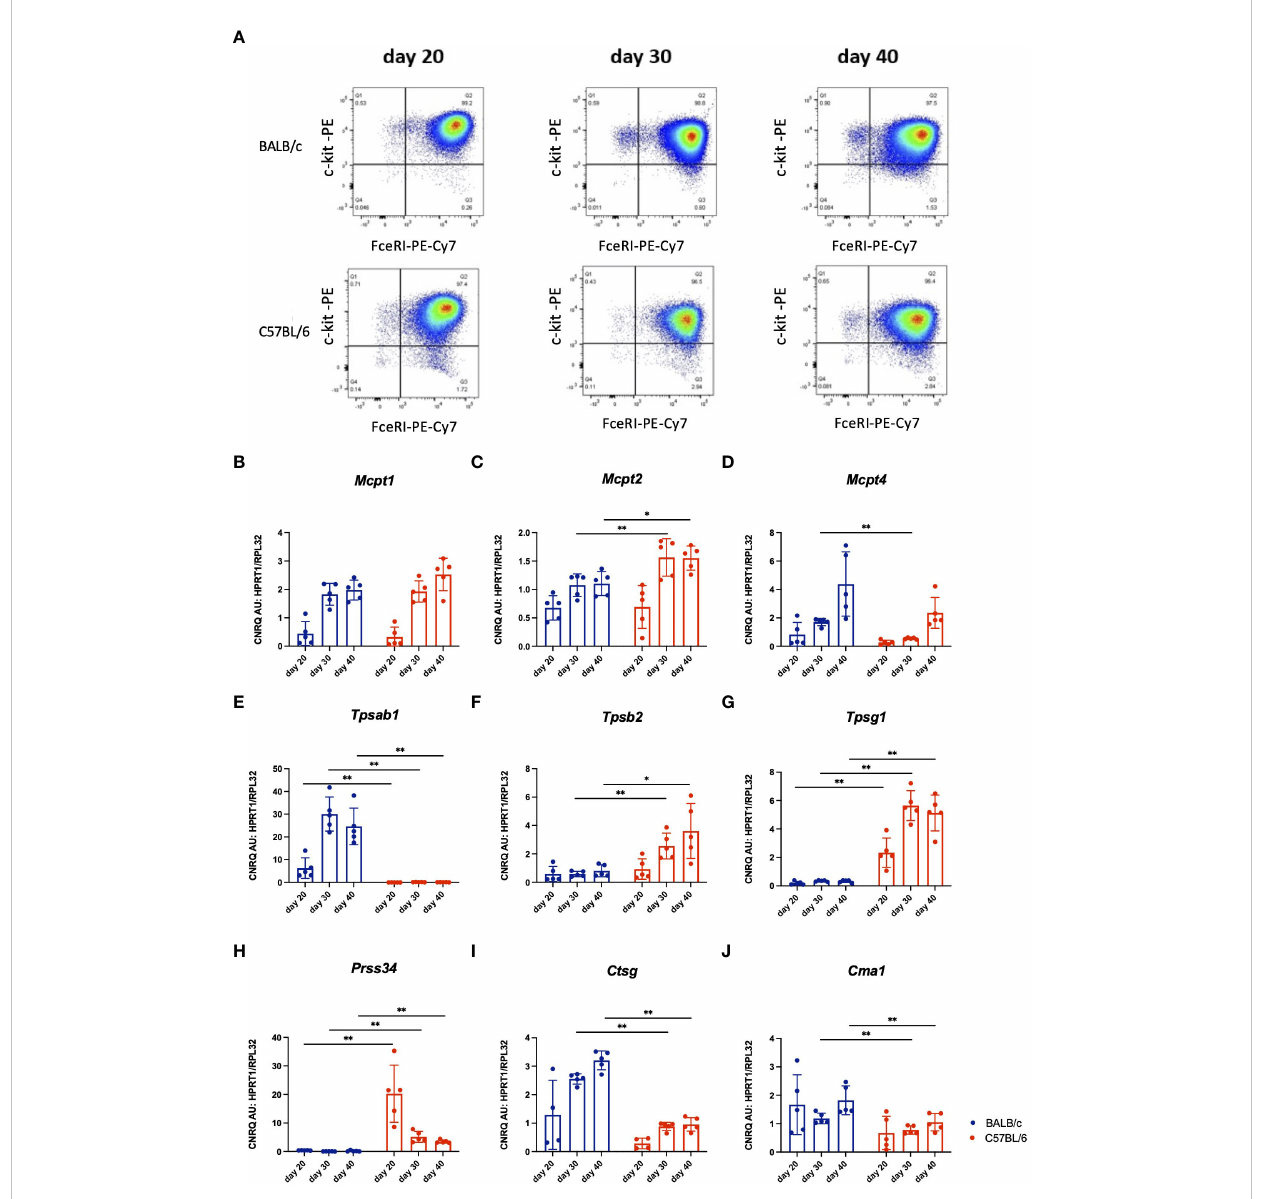
FIGURE 4 Representative dot plots of in vitro differentiated BMMCs from BALB/c and C57BL/6 mice cultured in vitro for 20, 30 or 40 days, respectively. Viable mast cells were analyzed for their expression of FceRI and c-kit using fl ow cytometry (A) . Next, gene expression analysis by RT-qPCR of mast cell proteases in these cultured BMMCs from I BALB/c and C57BL/6 mice was performed. Values of gene expression of Mcpt1 (B) , Mcpt2 (C) , Mcpt4 (D) , TpI1 (E) , Tpsb2 (F) , Tpsg1 (G) , Prss34 (H) , Ctsg (I) and Cma1 (J) were normalised to reference genes Hprt1 and Rpl32 . The data represent individual values, bars ± standard deviation (S.D.). Statistical signi fi cance between the groups was determined by Mann-Whitney test comparing BALB/c and C57BL/6 mice at each individual time point. The BMMCs were collected from two separate experiments, n=5 per group. *p < 0.05, **p <